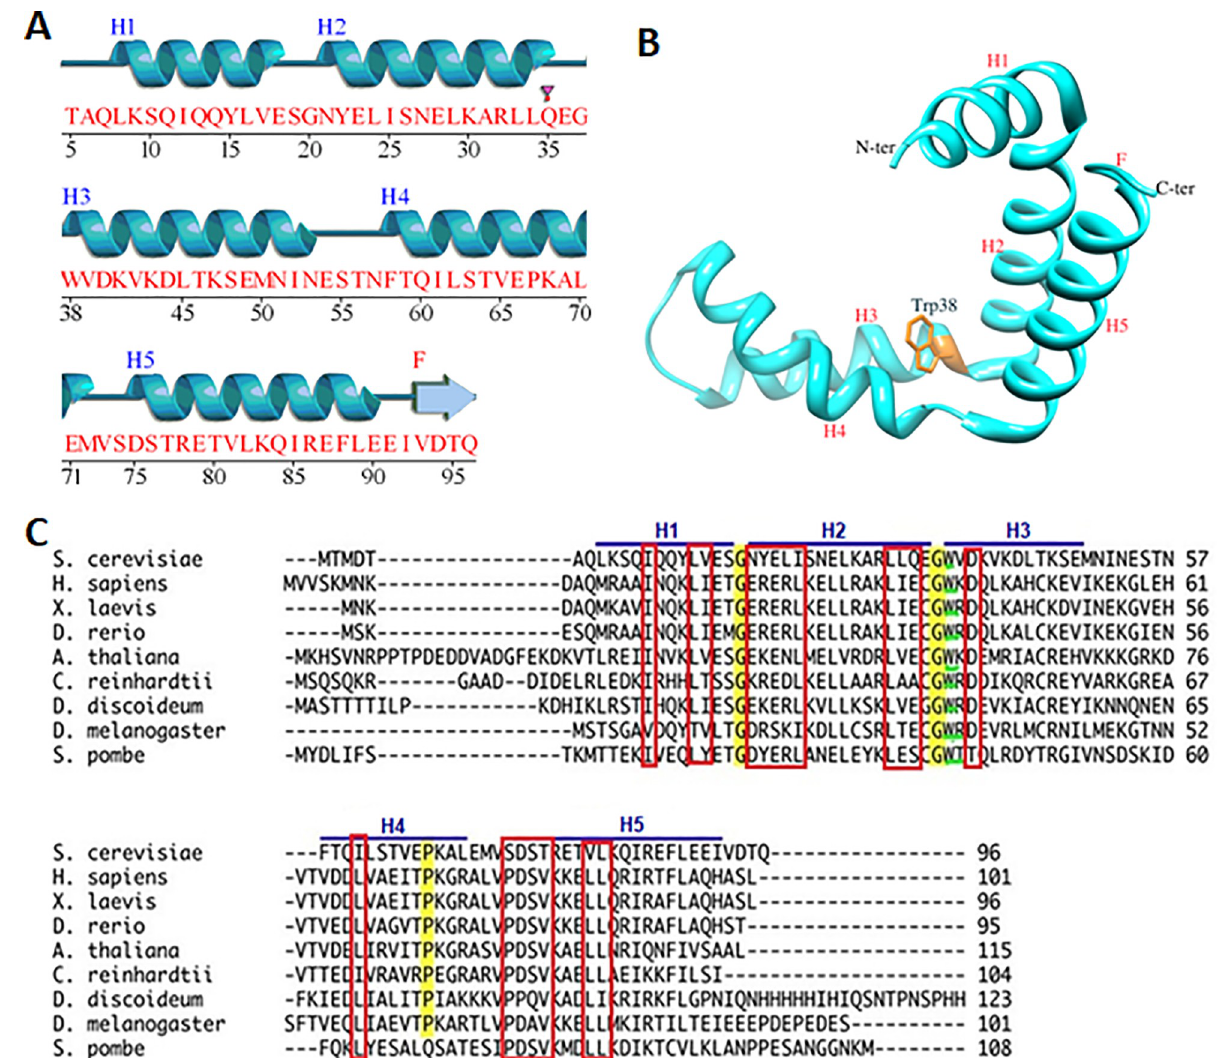
Fig 1. Sequence and structural analysis of Sus1. (A) Sequence along with the secondary structure was mapped using PDBsum server. H1- H5 represents the 5 helixes present in the Sus1. (B) The Sus1 structure was extracted from the PDB-3fwb using UCSF chimera. Helix and Trp38residue is labeled. (C) Multiple sequence alignment of the Sus1 from the different organism. The conserved residues are marked in the red rectangle. The conserved Gly residues between the H1-H2 and H2-H3 are highlighted in yellow color. The Pro67 residue is also highlighted in H4 helix. The conserved Trp residue is highlighted in green